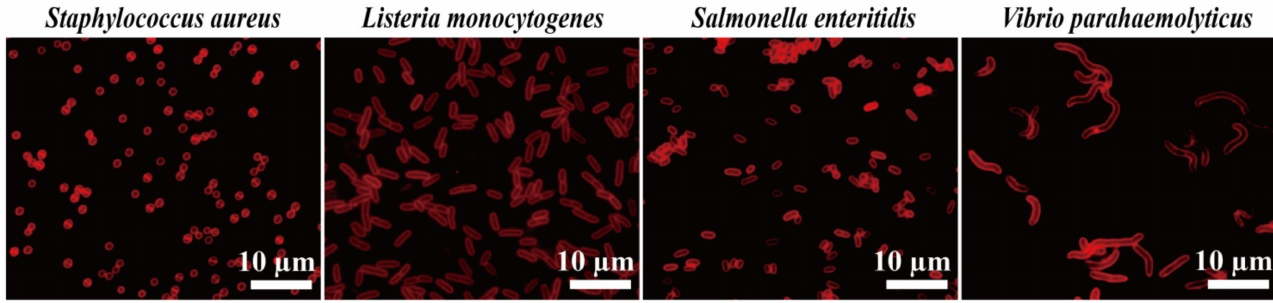
Figure 7. Fluorescence microscopy images of S. aureus , L. monocytogenes , S. enteritidis , and V. parahaemolyticus cells stained with 1000 ppm N-CQDs. Red fluorescence was detected under TRITC filter set. Scale bar represents 10 µ